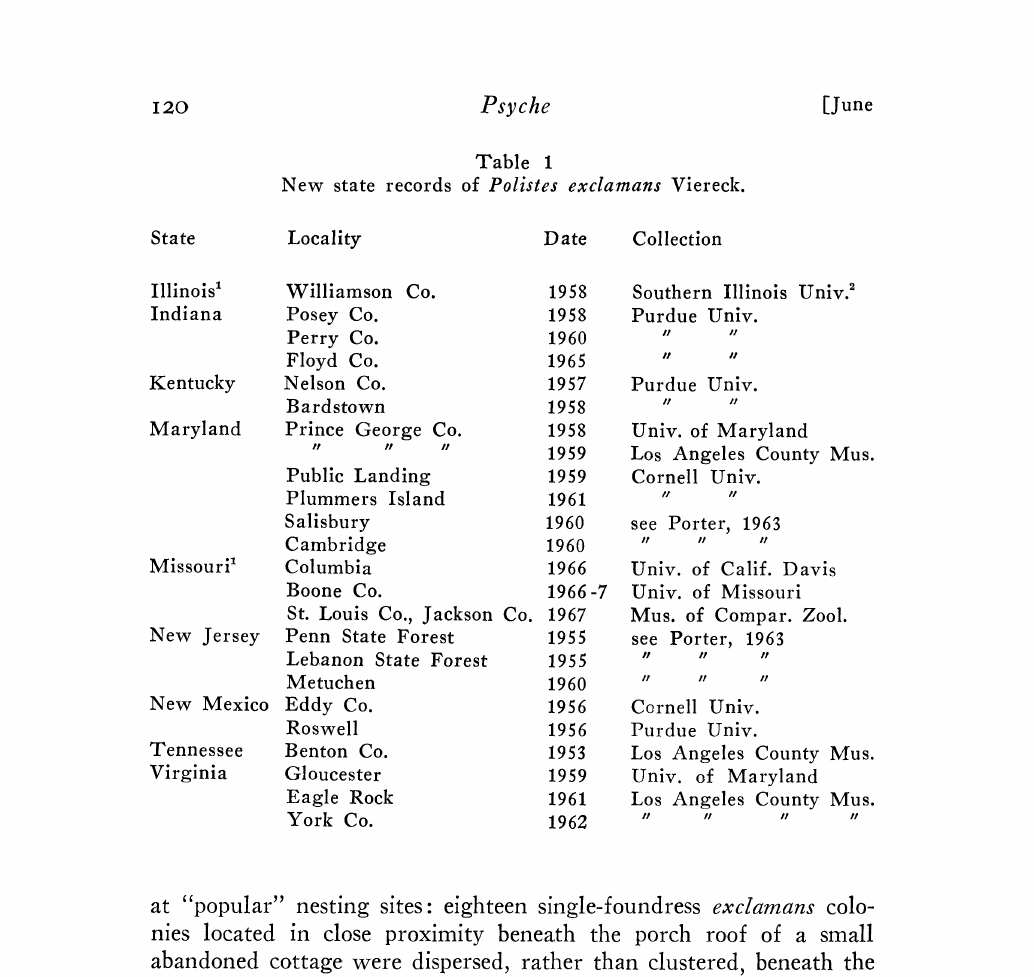
Table New state records of Polistes exclamans